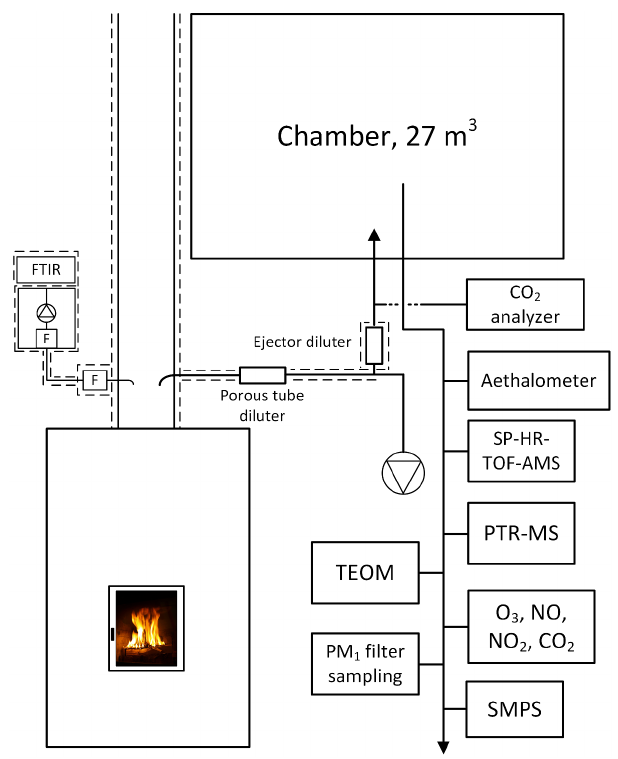
Figure 1. Experimental setup in the ILMARI combustion research facility at the University of Eastern